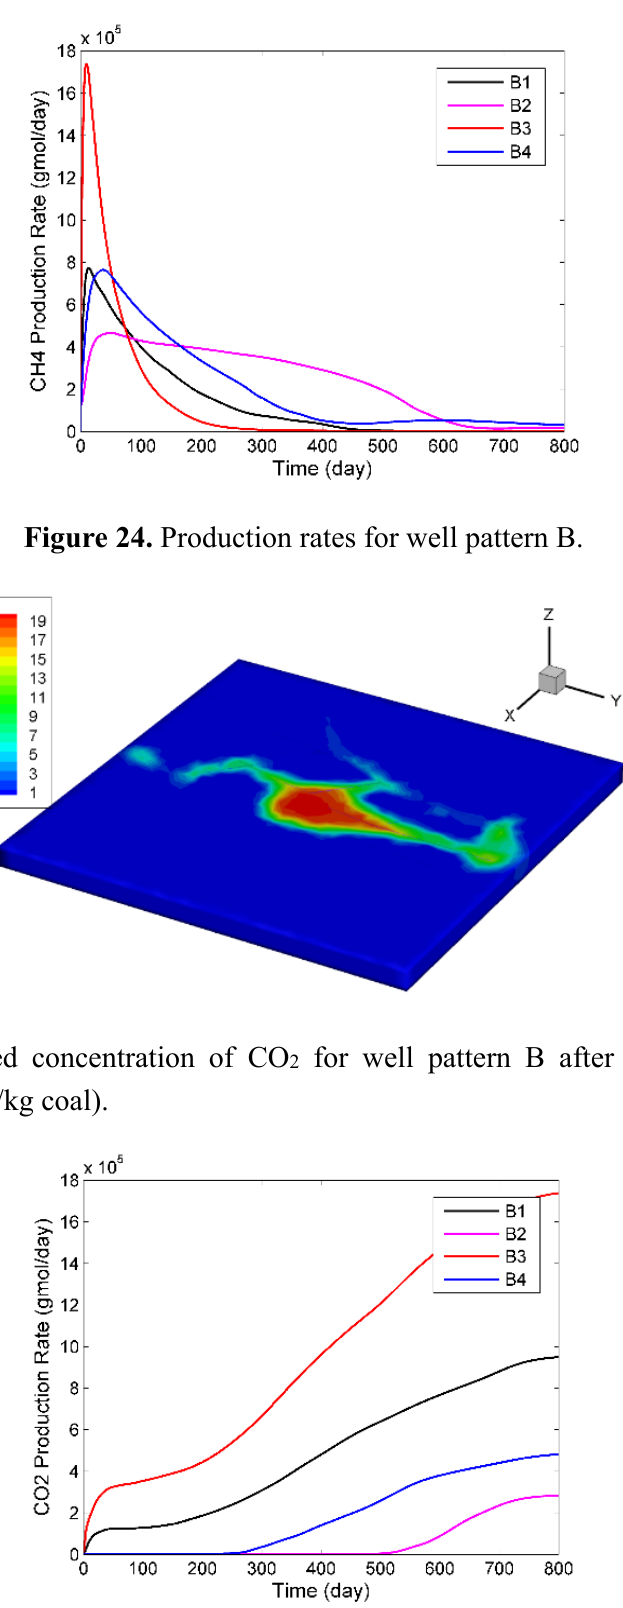
Figure 26. CO 2 breakthrough